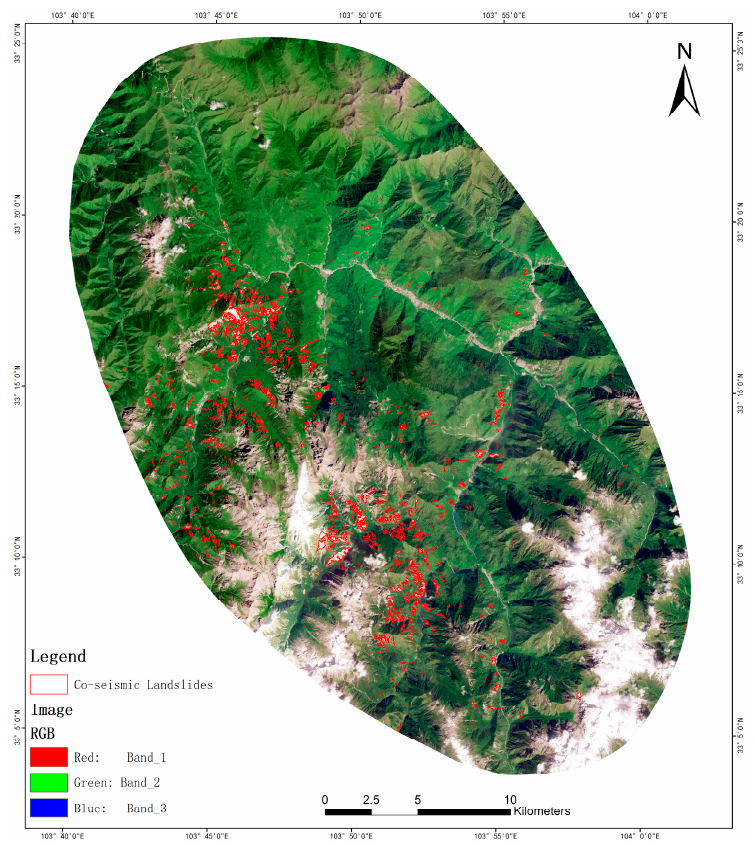
Figure 9. Distribution of coseismic landslides in the study area.